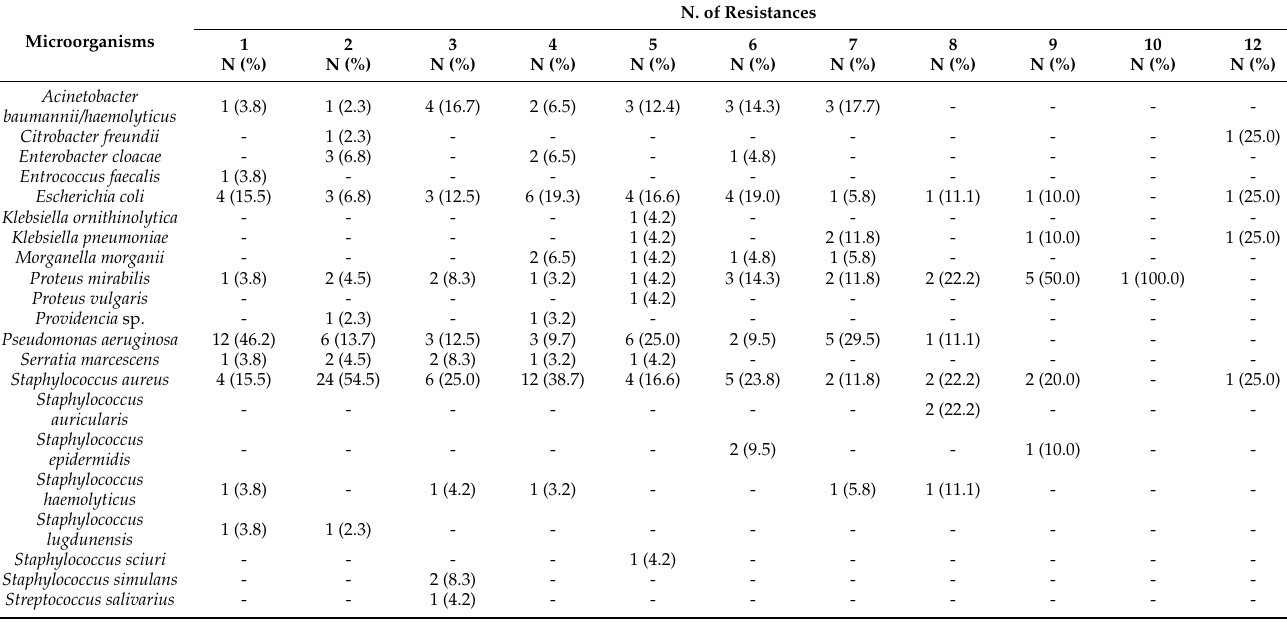
Table 6. Distribution of microorganisms stratified by number of